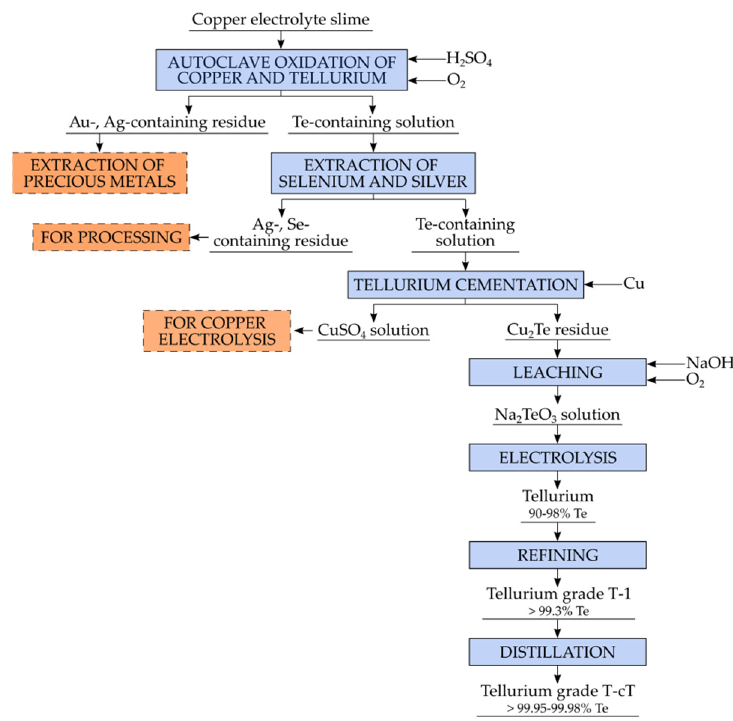
Figure 1. Copper electrolyte slime processing diagram.